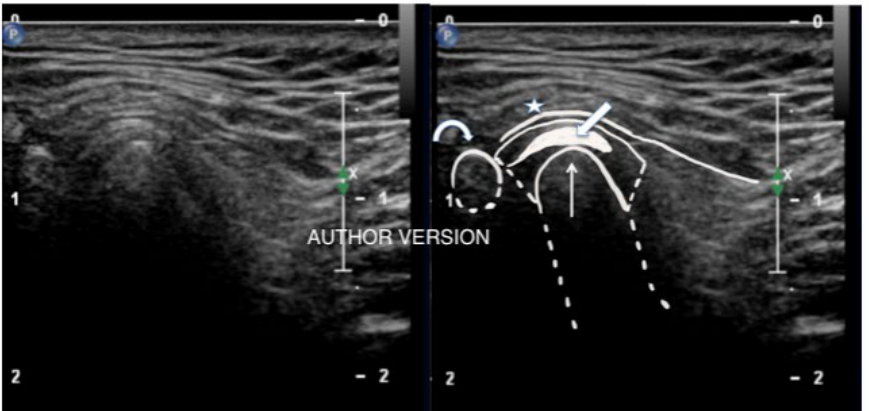
Figure 1. View of a healthy temporomandibular joint without pathological lesions with anatomical structures outlined.